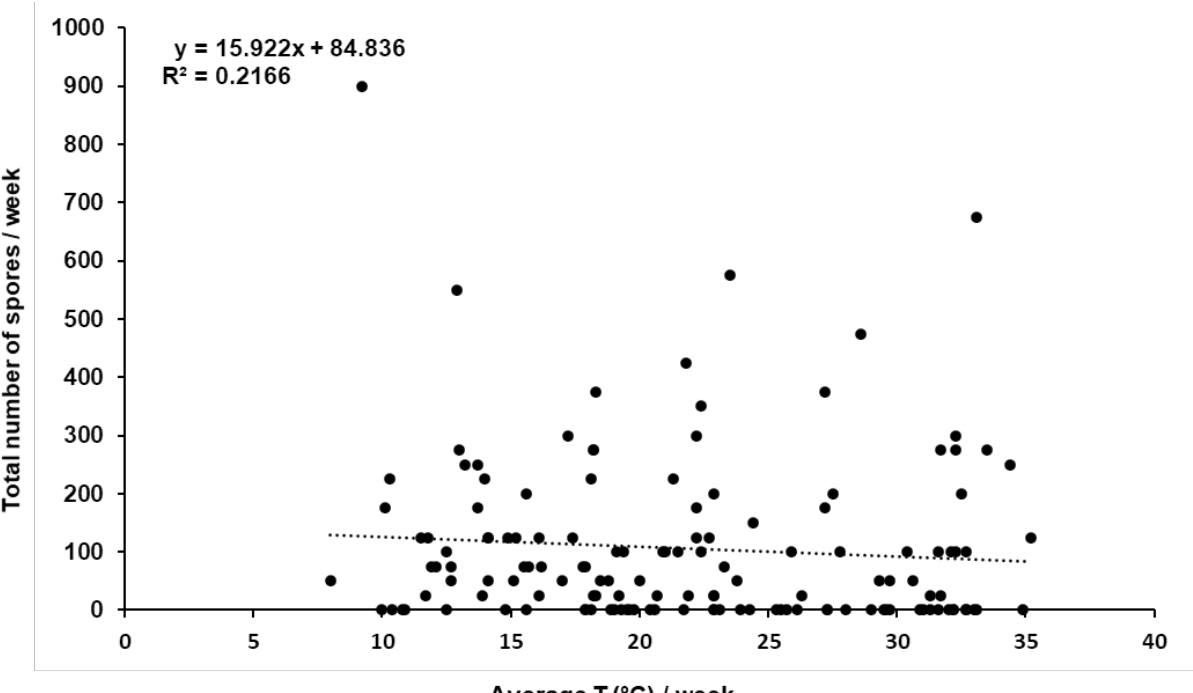
Figure 4. Scatter plot of the relationship between total spores trapped per week using glass microscope slides and average temperature. Lin- ear regression line and equation are also